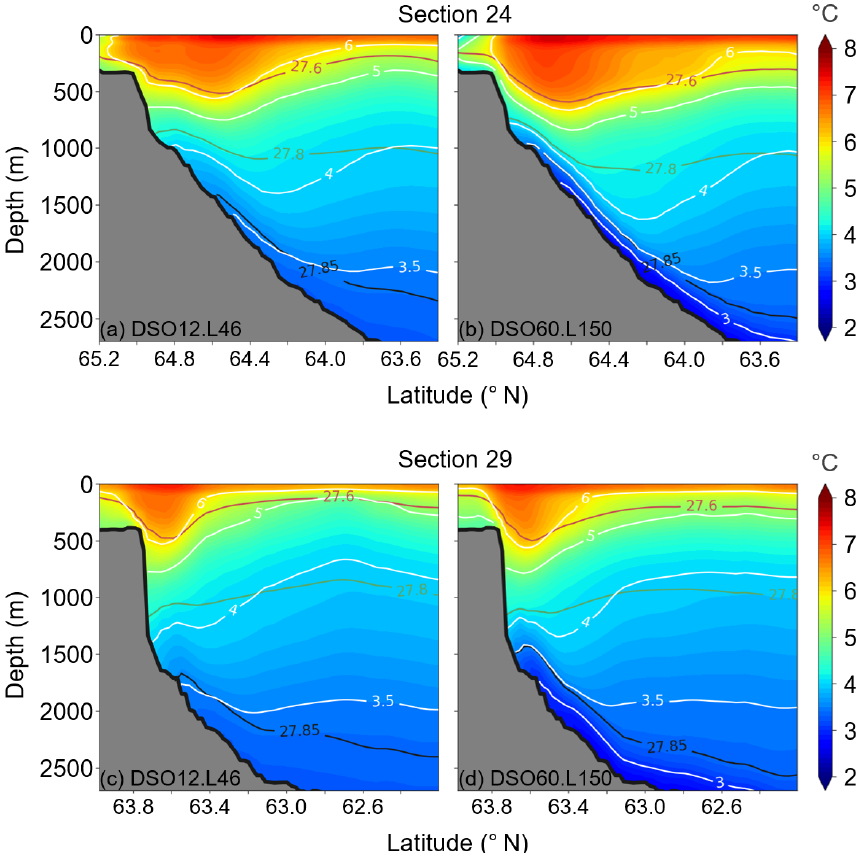
Figure 7. As in Fig. 6 at section 24 (TTO array) for (a) simulation DSO12.L46 and (b) simulation DSO60.L150, as well as at section 29 (Angmagssalik array) for (c) simulation DSO12.L46 and (d) simulation